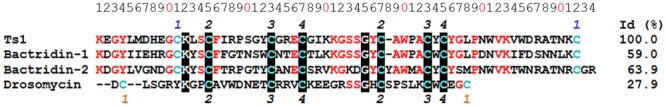
Multiple sequence alignment of Ts1 and AMPs. The alignment and identity (%) of Ts1 [PDB: 1NPI], drosomycin [PDB: 1MYN], bactridin-1 [Swiss-Prot: P0CF39] and bactridin-2 [Swiss-Prot: P0CF37] were performed using Clustal Omega version 1.2.4. The conserved amino acid residues are in red, and those highly conserved are highlighted in black. Cys residues are in blue. The numbers on the top and on the bottom refer to the disulfide bonds – the common bonds are in black; the orange and blue numbers represent the distinct bonds among drosomycin and the other toxins, respectively.